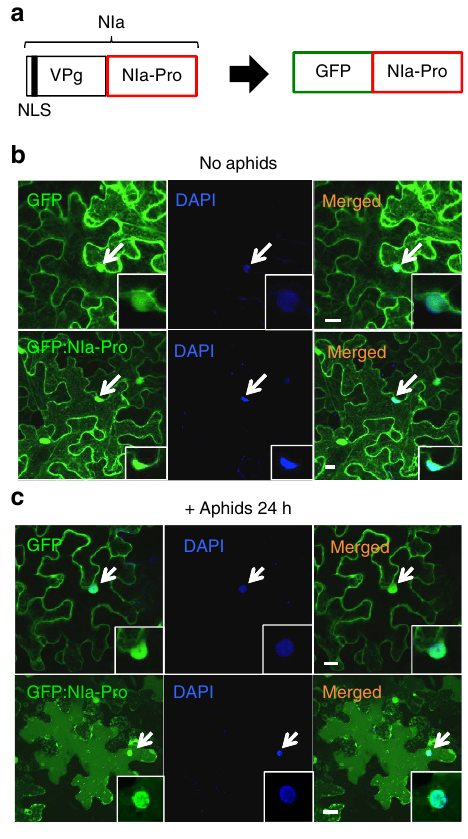
Figure 1 | NIa-Pro relocalizes in the cell with aphids present. ( a ) NIa-Pro can exist as a complex with another TuMV protein, the viral genome-linked protein (VPg) or in isolation during infection. In our study, only NIa-Pro was used. Images show confocal projections of agroinfiltrated N. benthamiana leaves with free GFP and GFP:NIa-Pro ( b ) without and ( c ) with aphids present. The first panel on the left shows GFP and GFP:NIa- Pro fluorescence in green. The second panel in the middle shows the nucleus of the cell in blue that was counterstained with DAPI. The third panel represents a merge of the first two panels, demonstrating GFP and GFP:NIa-Pro localizes to the nucleus. The small insert panels represent single confocal sections. With the presence of aphids, GFP:NIa-Pro relocalizes in the cell, whereas free GFP does not. The nuclei are indicated with white arrows. Scale bars, 20 m m. NATURE COMMUNICATIONS|8:14493|DOI: